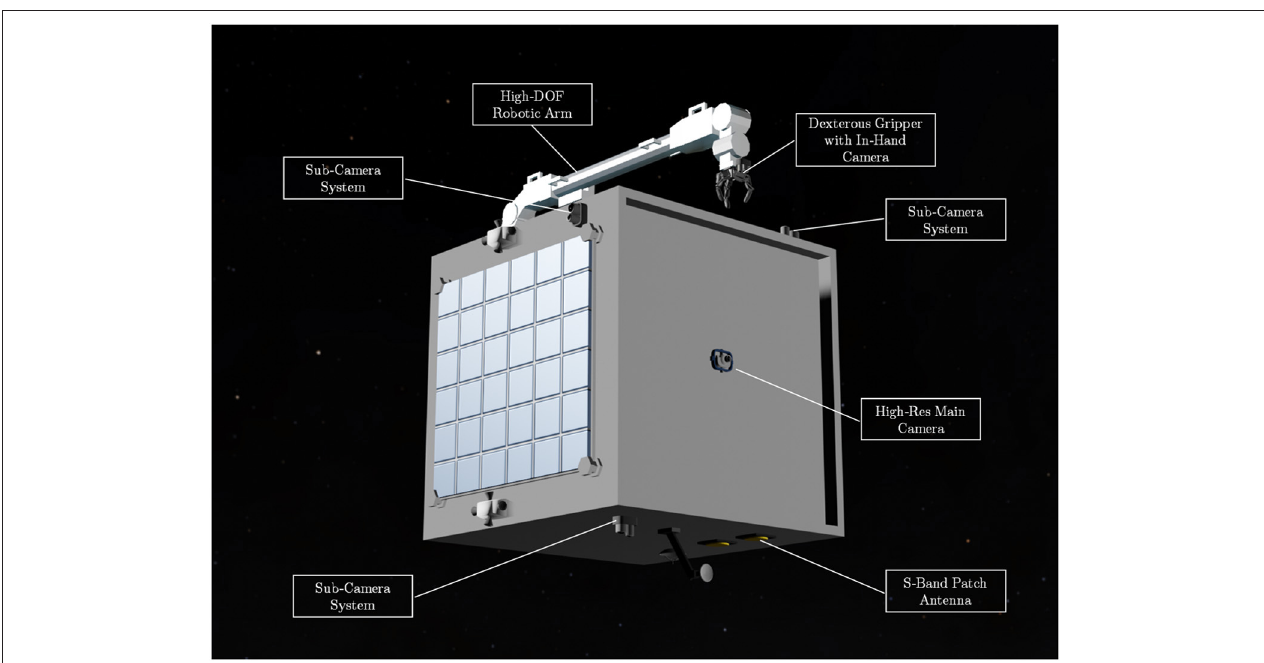
FIGURE 1 | The design of the intelligent orbital service spacecraft—AISAT: it comprises a monocular camera network and a 7-DOF (degrees of freedom) robotic arm as key components for the intelligent visual Guidance, Navigation, and Control (GNC) subsystem. The spacecraft also has a dexterous gripper for target capture and S-band patch antenna for basic house-keeping and the intelligent system